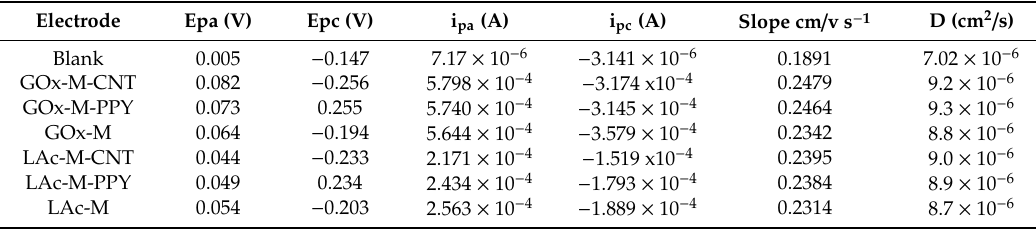
Table 1. Calculation of bioanode and biocathode